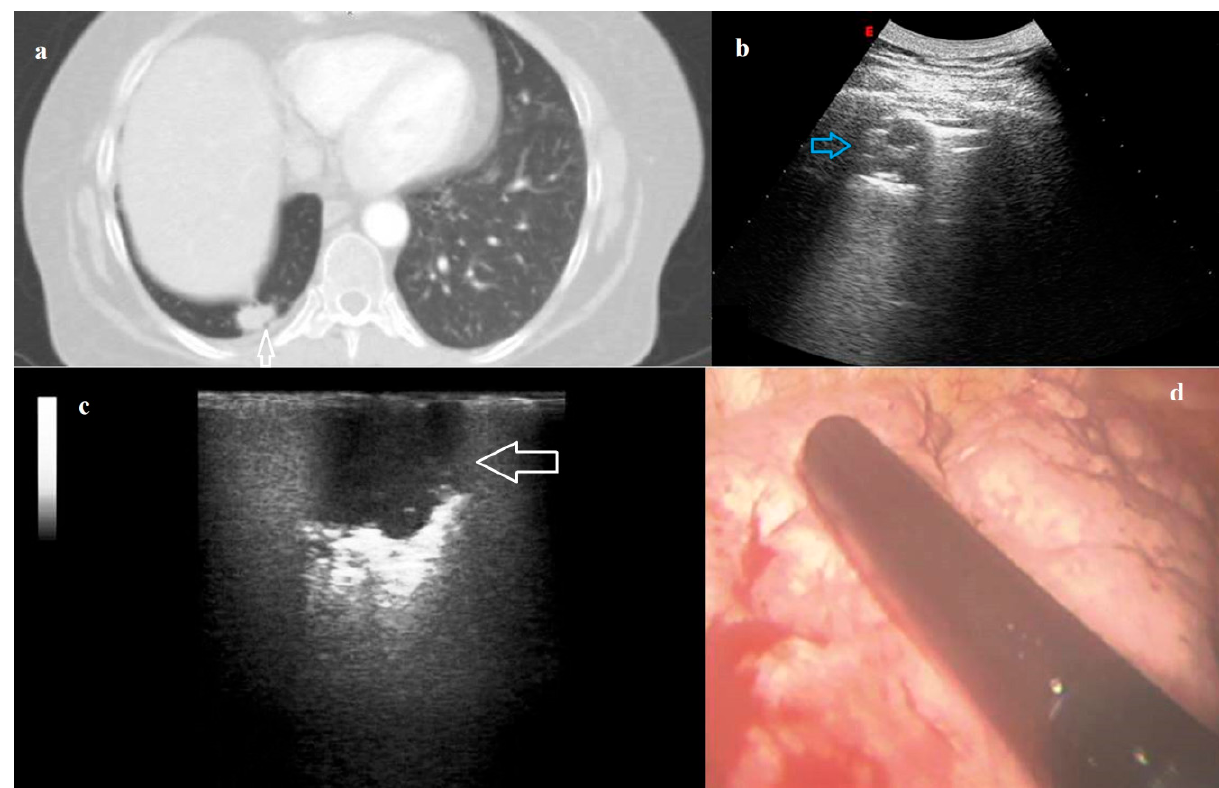
Figure 3. ( a ) Axial computed tomography (CT) scan showing a pulmonary nodule (white arrow) in the right lung. ( b ) Transthoracic ultrasound (TUS) scan (convex probe, 5 MHz) showing the right subpleural nodule adhering to pleural surface (blue arrow). ( c ) Intraoperative lung ultrasound during Video-Assisted Thoracoscopic Surgery (VATS-US) showing the pulmonary nodule (white arrow) with a hypoechoic pattern and jagged margins. ( d ) Photograph showing the intracavitary laparoscope probe (8–12 MHz) placed on the right lung during Video-Assisted Thoracoscopic Surgery (VATS). The final histological diagnosis was pulmonary adenocarcinoma. Table 4. Ultrasound characteristics of nodules examined using TUS compared to those recorded at ILU and their relationship to the pathologic nature of the nodule.